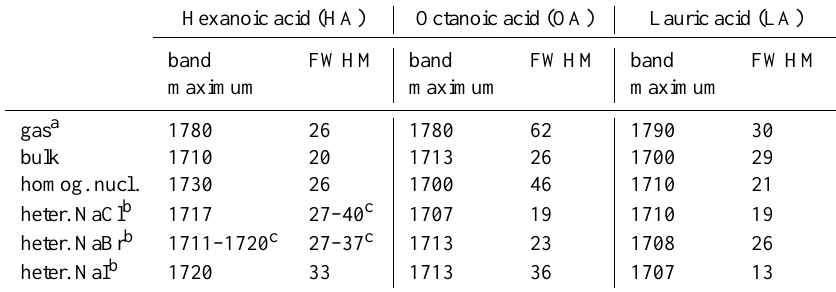
Table 2. Wave numbers of the C=O stretching band in various conditions for HA, OA and LA. Units in cm − 1 .